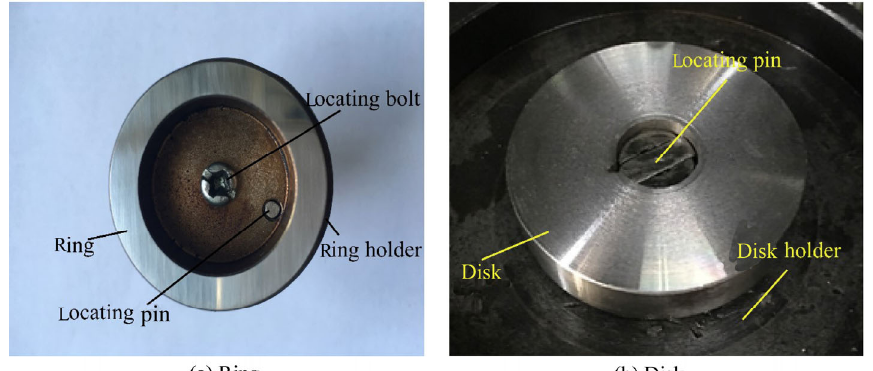
Fig. 2 Installation of ring and